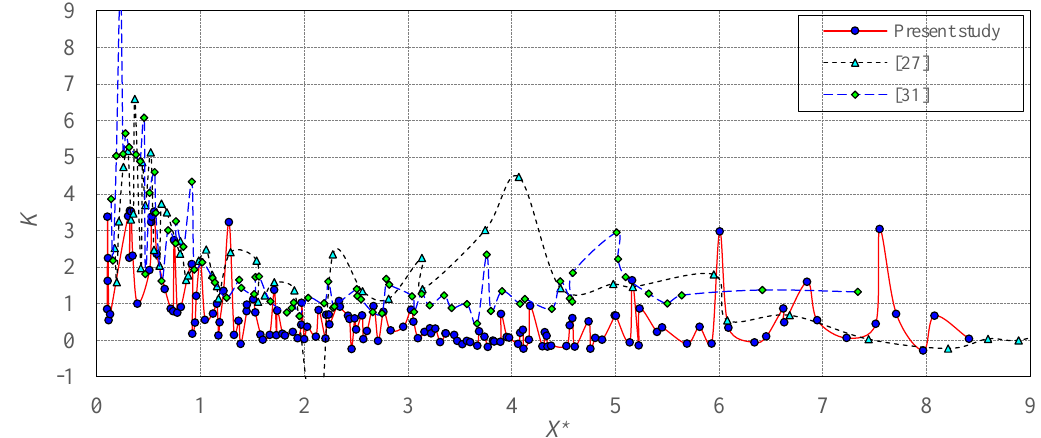
Figure 5. Kurtosis coefficient along the stilling basin.